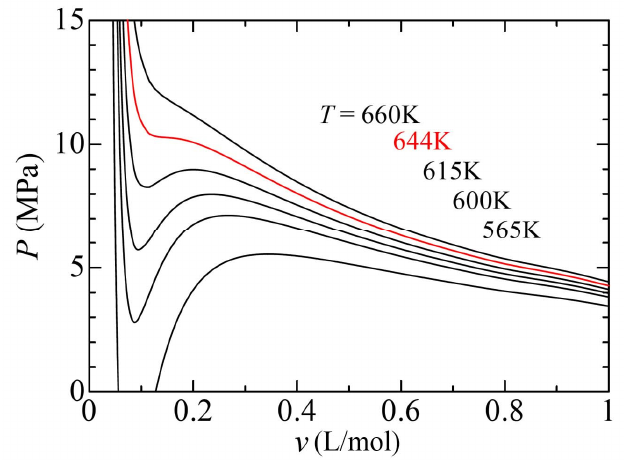
Figure 6. Pressure isotherms evaluated using the RISM–KH theory. This figure is reprinted with permission from JCP , 2014 , 140 , 104511. Copyright 2014 AIP Publishing.